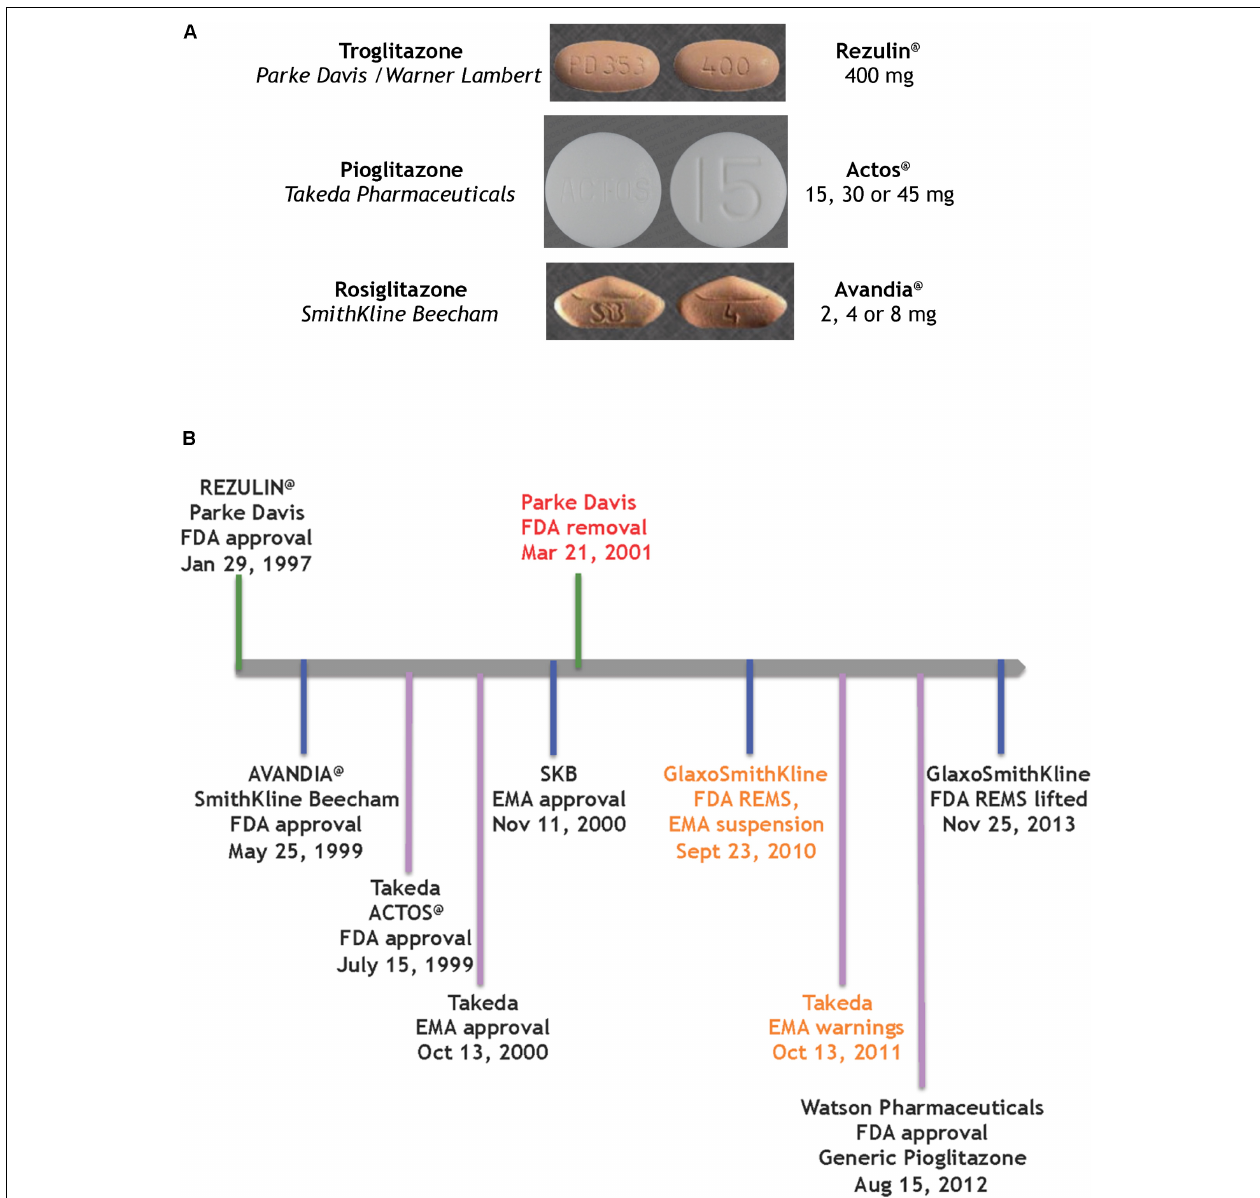
FIGURE 2 | Glitazones as medicines (A) the glitazone pills (Wishart et al., 2018), (B) timeline of key regulatory events for the glitazones.